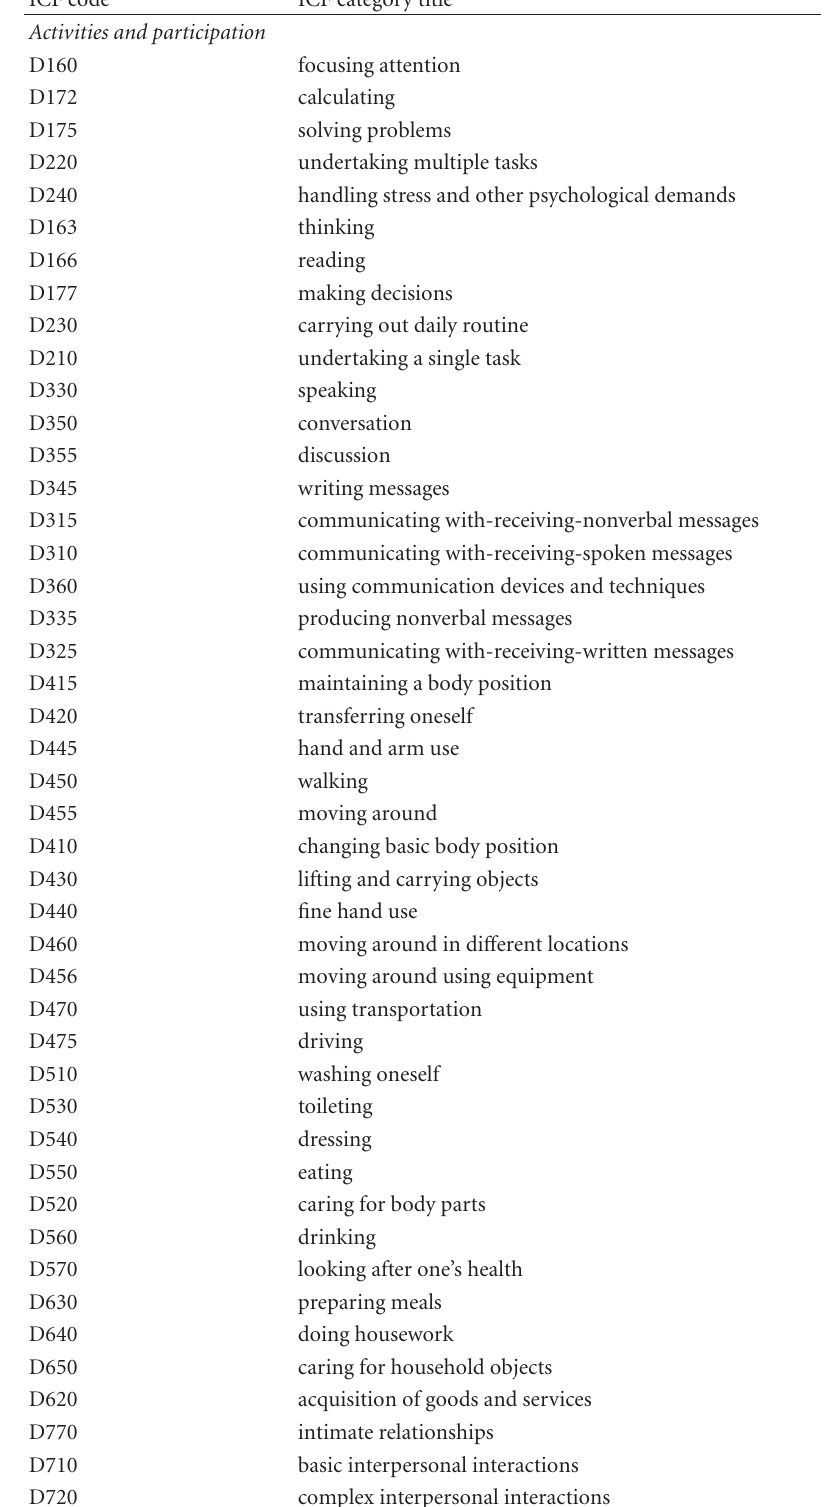
Table 3: International classification of functioning, disability and health (ICF) categories for the components: “activities and participation” and “environmental factors” included in the “core” set for persons with MS for comprehensive multidisciplinary